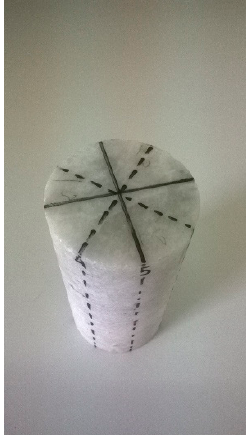
Figure 3. Straight parallel lines drawn along the longitudinal axis of each specimen. Appl. Sci. 2018 , 8 , x FOR PEER REVIEW